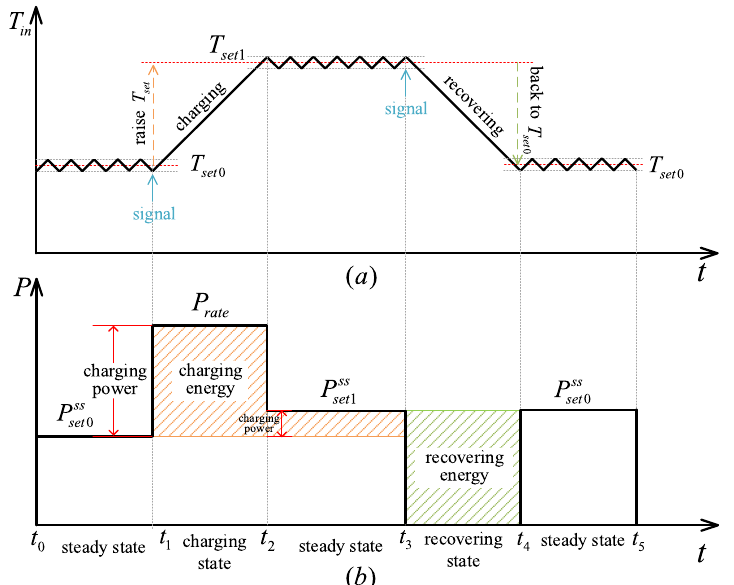
Fig. 4 Charging process of the VESS in heating mode: ( a ) the varying curve of the indoor temperature and ( b ) the varying curve of the VESS ’ power consumption